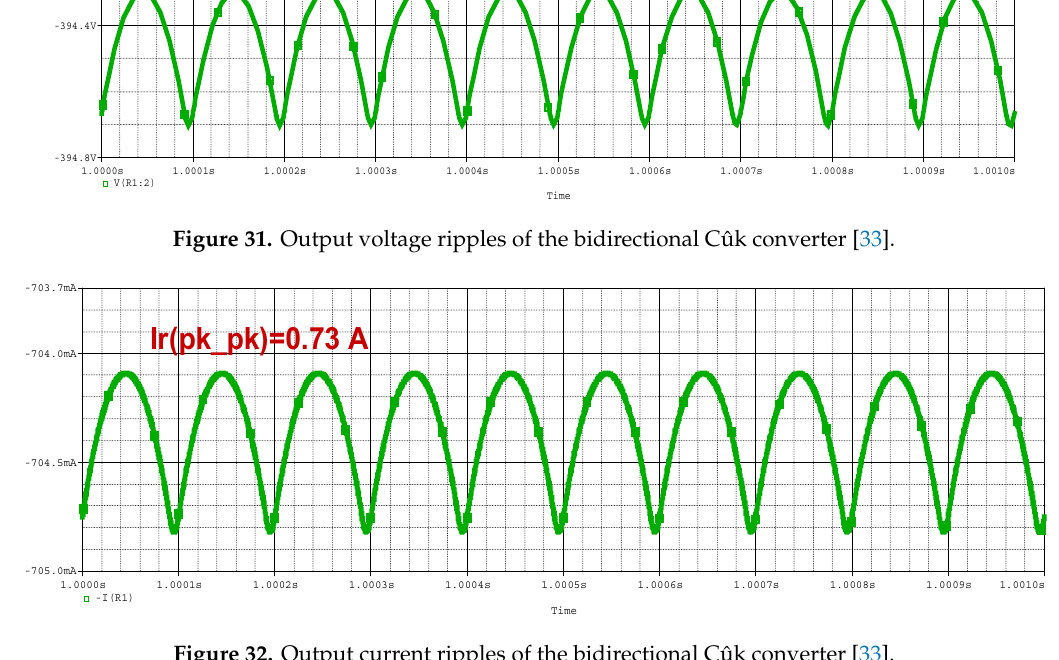
Figure 33. Voltage across switch “s” of the bidirectional CUK converter for a 400-V output [33].